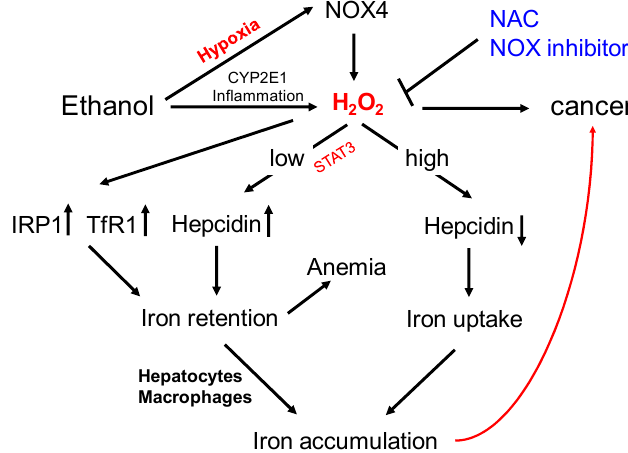
Figure 7. Scheme of molecular changes on iron metabolism mediated by alcohol and the role of hepcidin (adapted from [3]). Hypoxia and oxidases, such as NADPH oxidase 4 (NOX4), both contribute to H 2 O 2 -mediated hepcidin regulation. While low H 2 O 2 levels could explain hepcidin induction via STAT3 and anemia, toxic levels cause suppression of hepcidin, ultimately leading to iron accumulation. The co-presence of hypoxia, reactive oxygen species, and iron are mandatory inducers of cancer. The novel concept may help in developing novel targeted therapies e.g. against NOX using NOX inhibitors. They could also explain the protective effects of i.v. N-acetylcysteine (NAC) infusions that seem to improve alcohol-induced liver